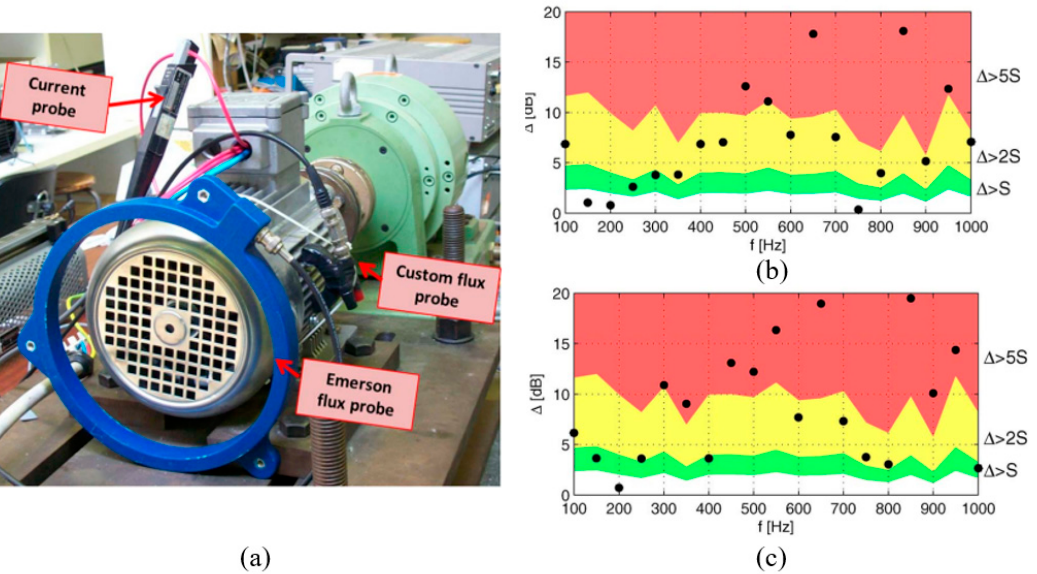
Figure 19. ( a ) Applied probes for amplification and filtering ( b ) frequency plot for the damaged bearing seal condition and ( c ) hole in outer race fault [60].